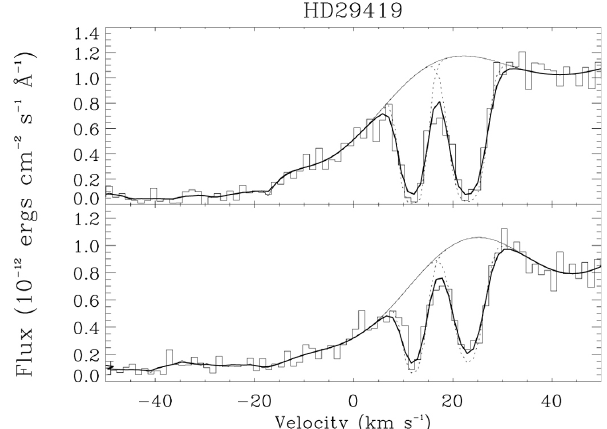
Fig. 1. An example of the data used by Redfield and Linsky (2004) to deduce properties of turbulence in the Local Clouds. The figure shows a portion of the spectrum of the star HD29419, around the h and k lines of MgII. The spectral flux is plotted versus wavelength, with wavelength converted to a Doppler shift relative to the Sun. The upper panel shows the spectrum in the vicinity of the MgII k line, and the bottom panel shows the MgII h line. The thin solid line shows the estimate of the stellar photospheric continuum. The two absorption lines result from absorption in two clouds of the VLISM, the LIC cloud (absorption component at +25kms − 1 ), and the Hyades Cloud (component at +12kms − 1 ). For each component, it is possible to fit for the line centroid, the line width b , and the strength of the line, which is related to the column density of MgII. Figure taken from Redfield and Linsky